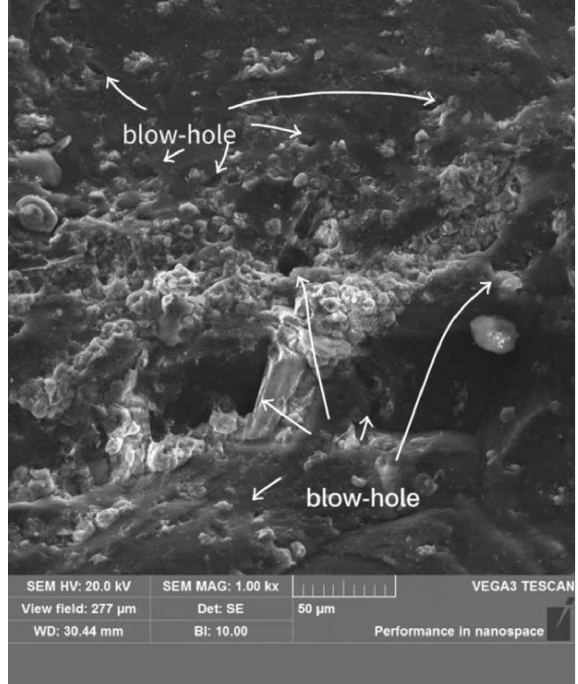
Figure 1: Directional generation of stomata.